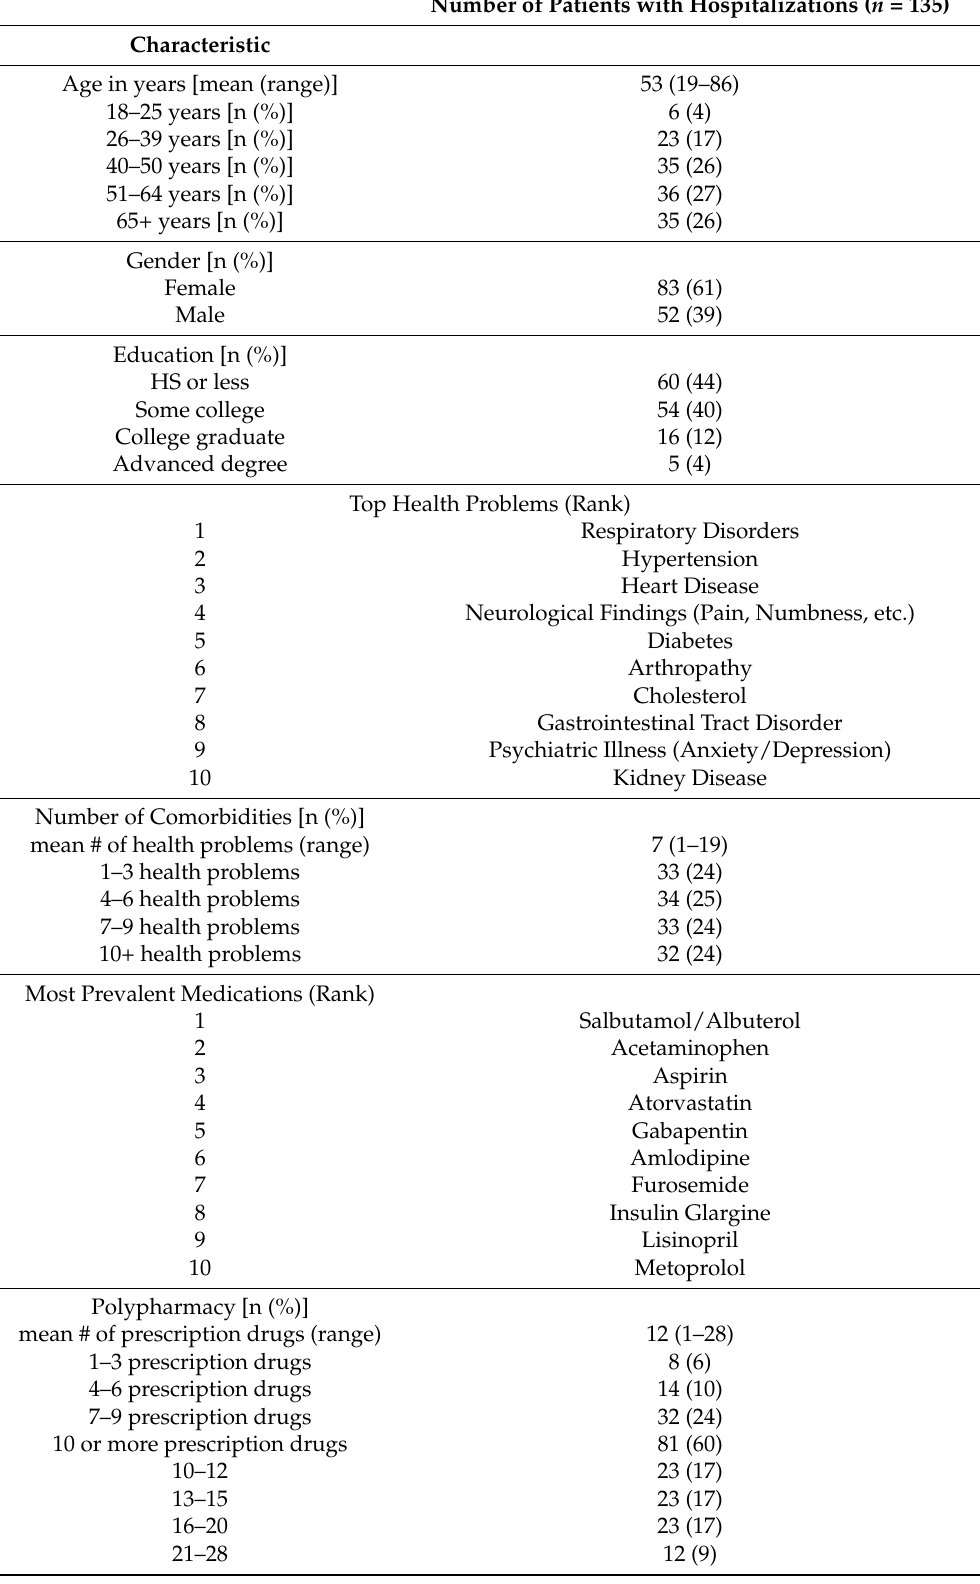
Table 1. Baseline characteristics of hospitalized African American patients. Percentages (%) may not sum to 100 due to rounding. Reflects UChicago, Northwestern, University of Illinois at Chicago.